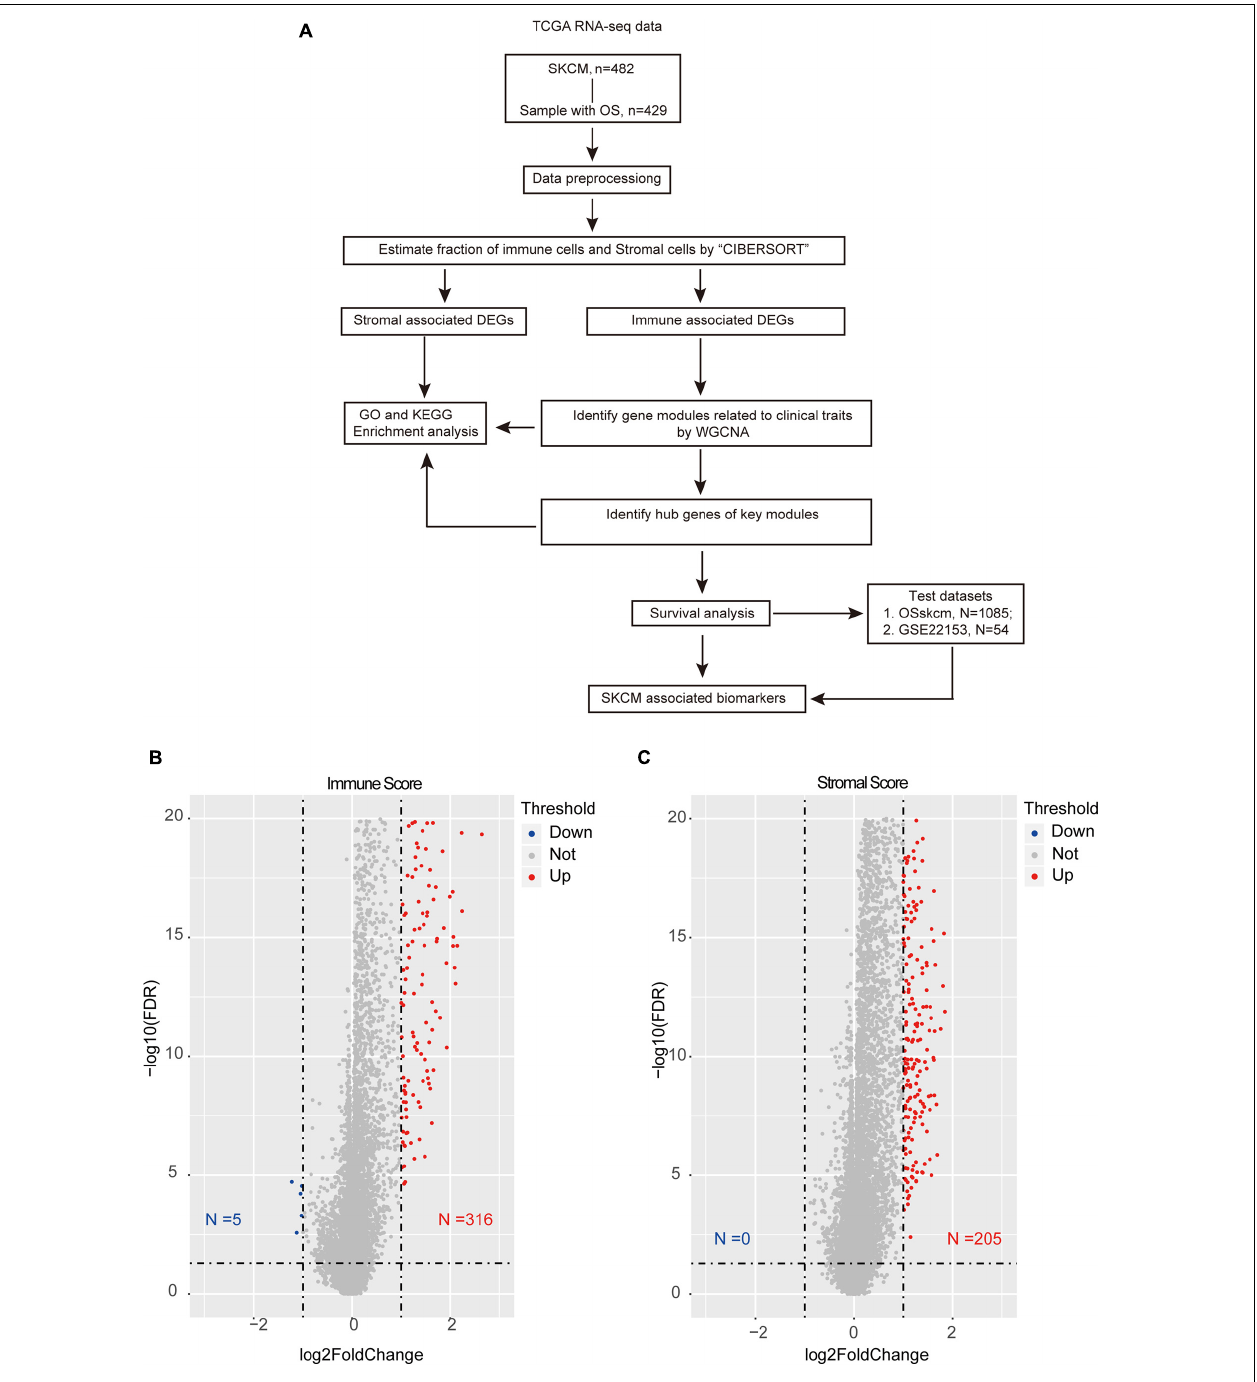
FIGURE 1 | Overview of the integration analysis. (A) Workflow of the analysis. (B) Volcano plot showing the differentially expressed genes (DEGs) between high- and low-immune-score samples. (C) Volcano plot showing the DEGs in high and low stromal score groups. The red color indicates the up-regulated genes, while blue represents the down-regulated ones. The horizontal dotted line represents a false discovery rate equal to 0.05, and the vertical dotted line represents a fold change equal to 2 or 0.5.